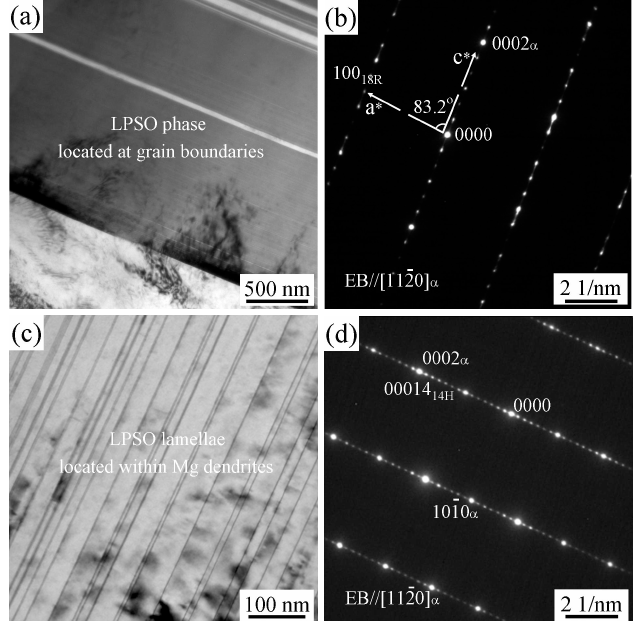
Figure 3. Transmission electron microscopy (TEM) bright field images and selected area electron diffraction (SAED) patterns of the long period stacking ordered (LPSO) phases in the as-cast Mg95.5Y3Zn1.5 alloy: ( a , b ) LPSO phase located at the grain boundaries; ( c , d ) LPSO lamellae located within the Mg